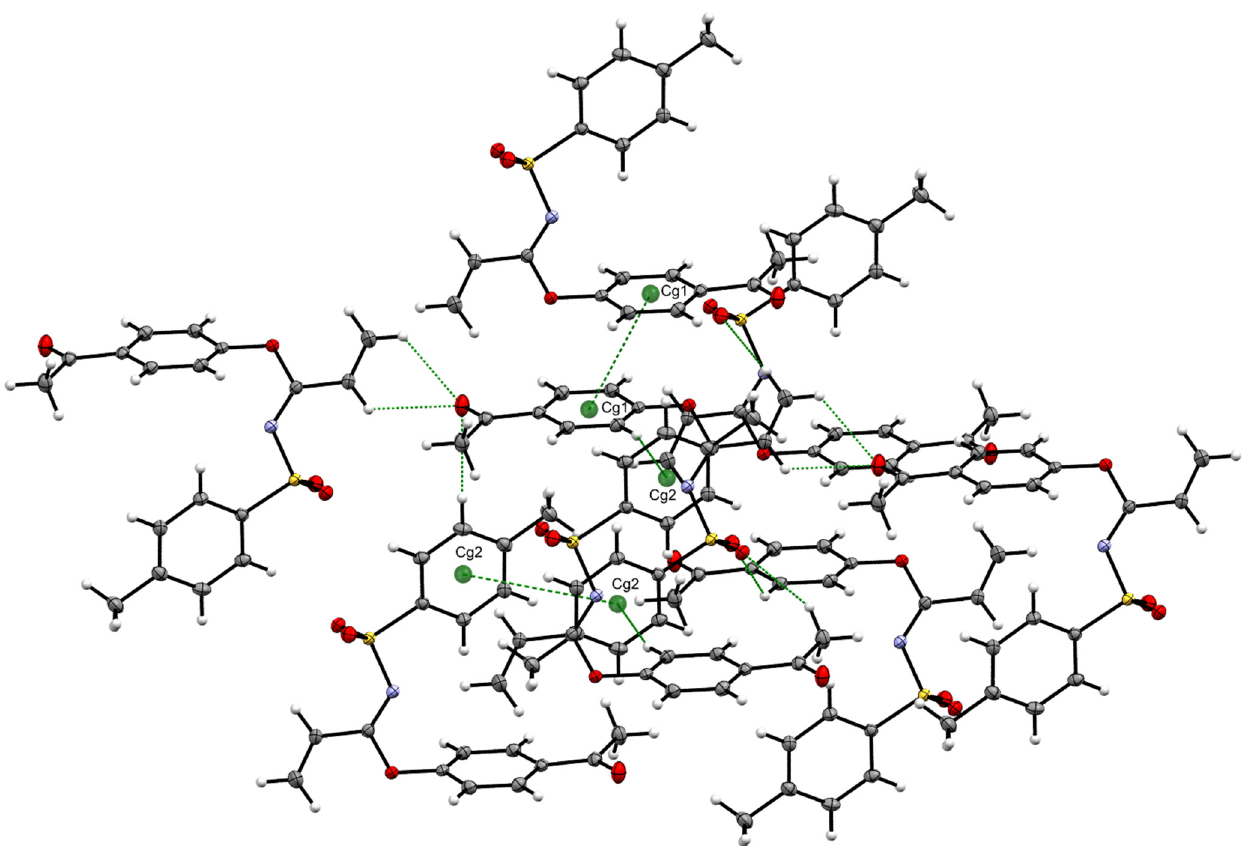
interactions with C and O atoms, noting an important contribution by H···H (41.1%) and